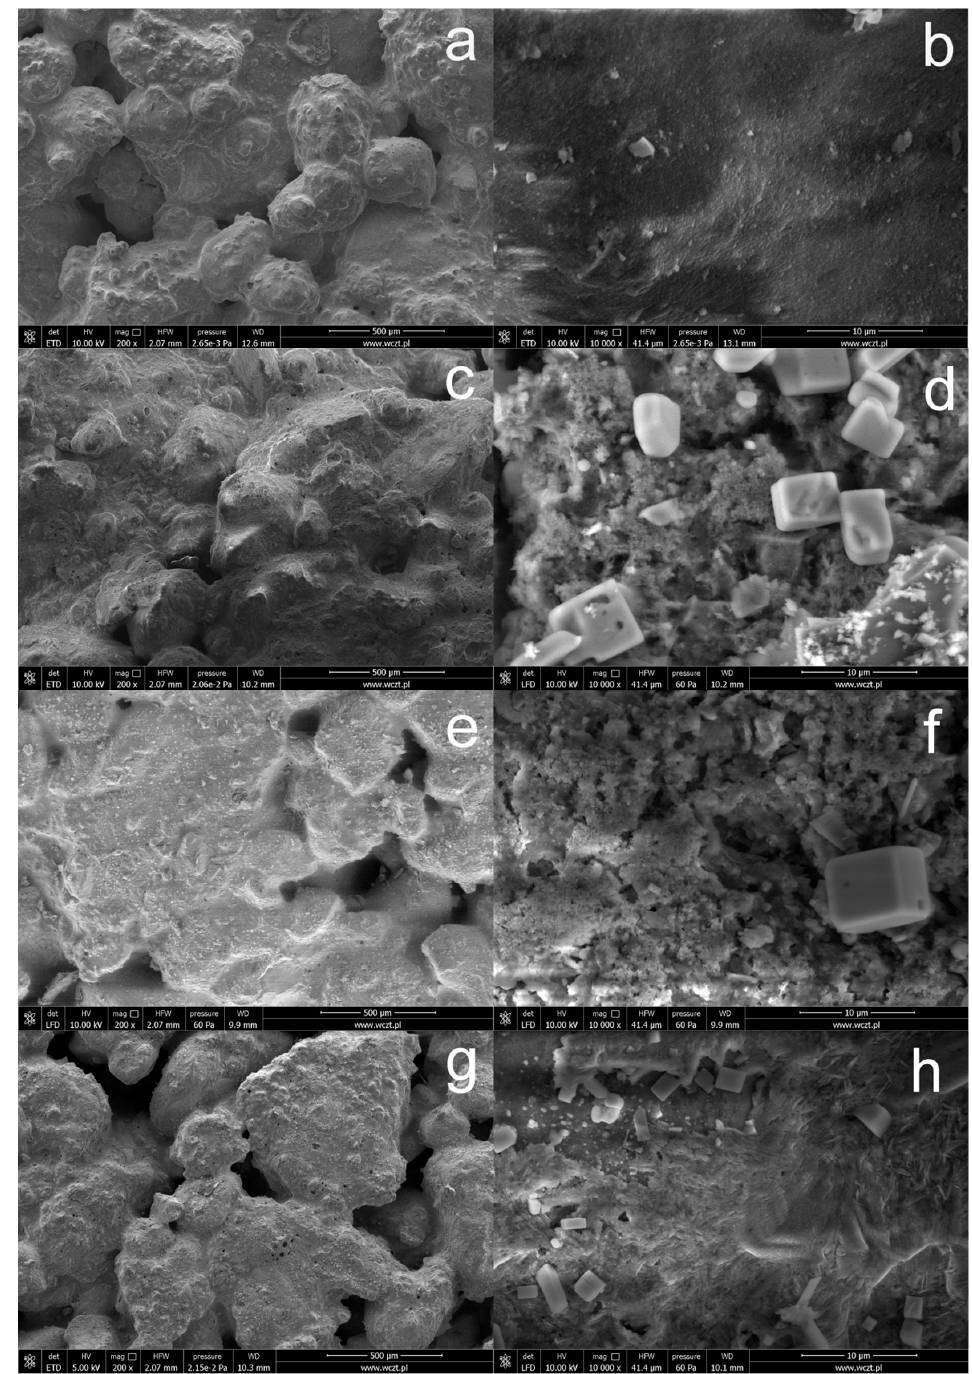
Figure 2. SEM images of unmodified concrete ( a , b ) and concrete with a modified surface by OFTES solutions: sample F1 ( c , d ), F2.5 ( e , f ), and F5 ( g , h